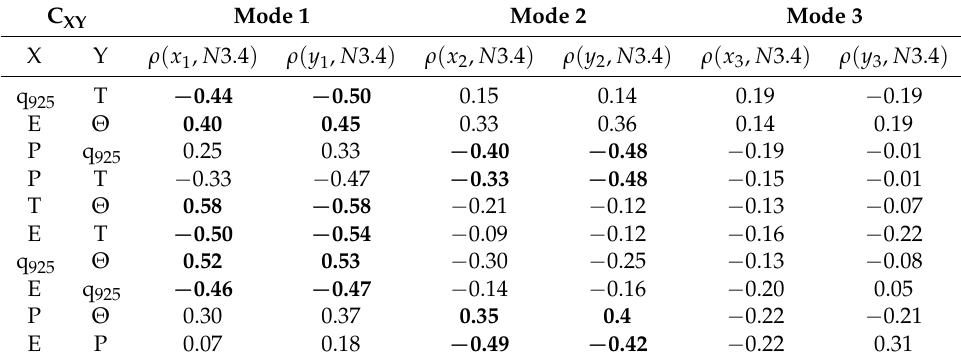
Table 2. Correlation between MCA-series with the Niño 3.4 index, ρ ( x k , N 3.4 ) and ρ ( y k , N 3.4 ) for the three leading MCA-modes. Highest correlation value of each pair is denoted in